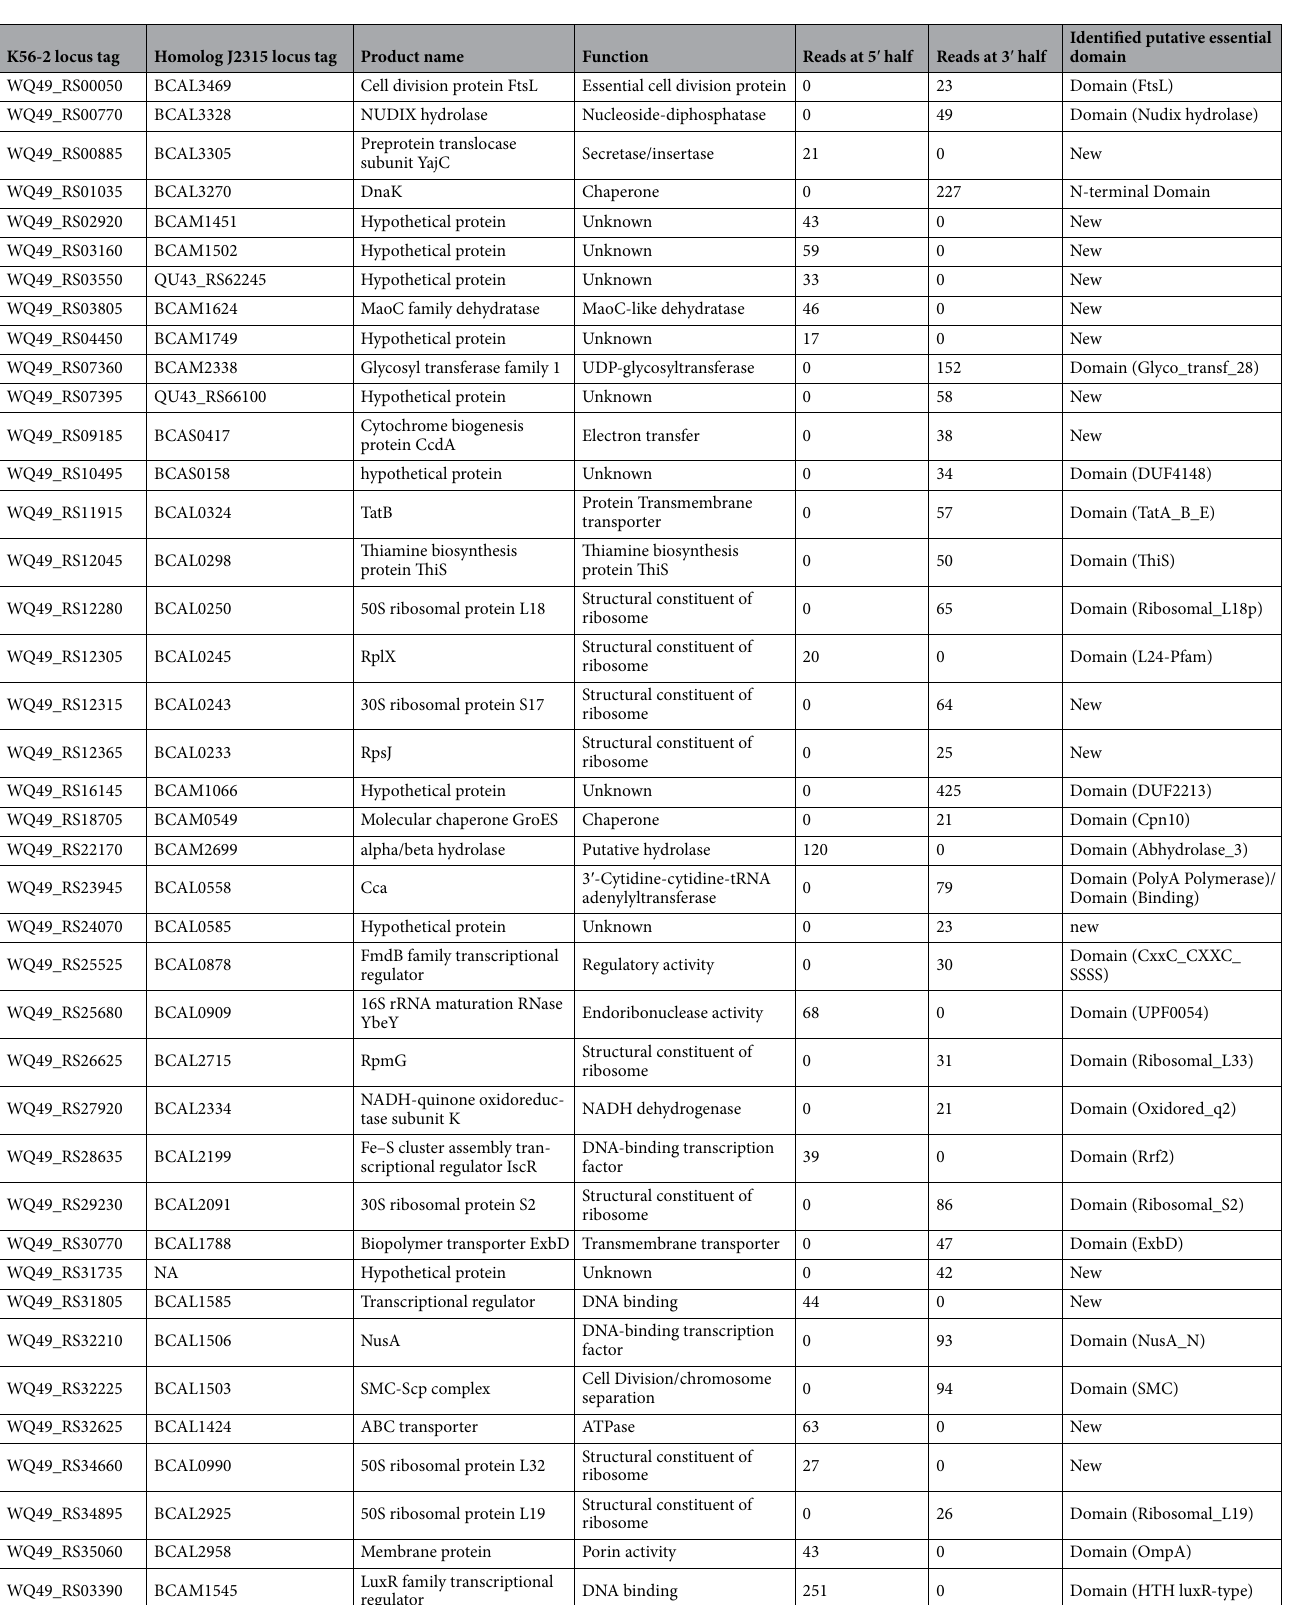
Table 1. Putative essential genes and domains identified based on biased transposon